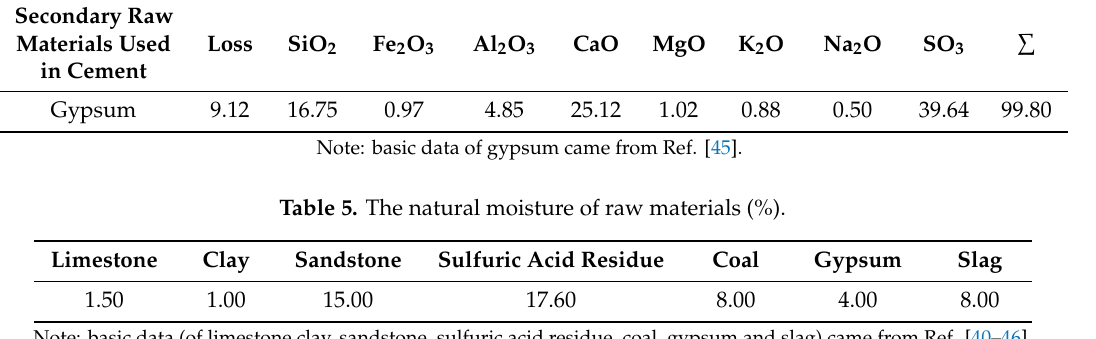
Table 4. Chemical analysis of the secondary raw material gypsum (%).